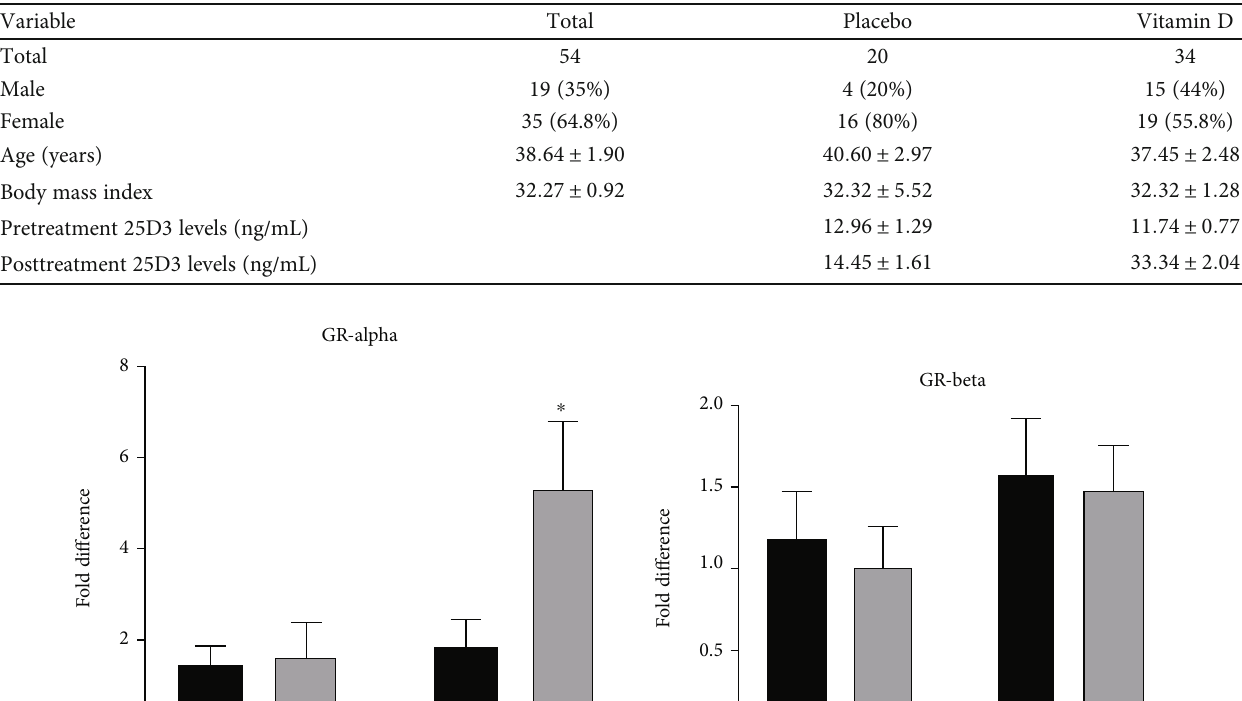
Table 1: Clinical characteristics of patients who received vitamin D or placebo for eight weeks.